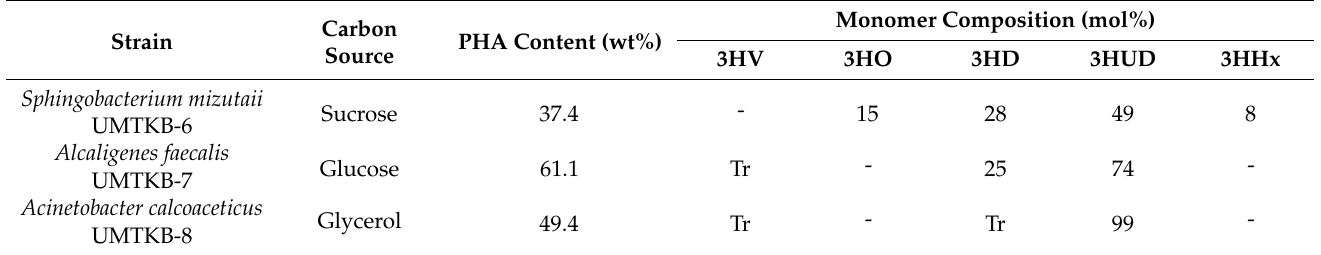
Table 2. PHA content and monomer composition of PHA biosynthesised by Sphingobacterium mizutaii UMTKB-6, Alcaligenes faecalis UMTKB-7, and Acinetobacter calcoaceticus